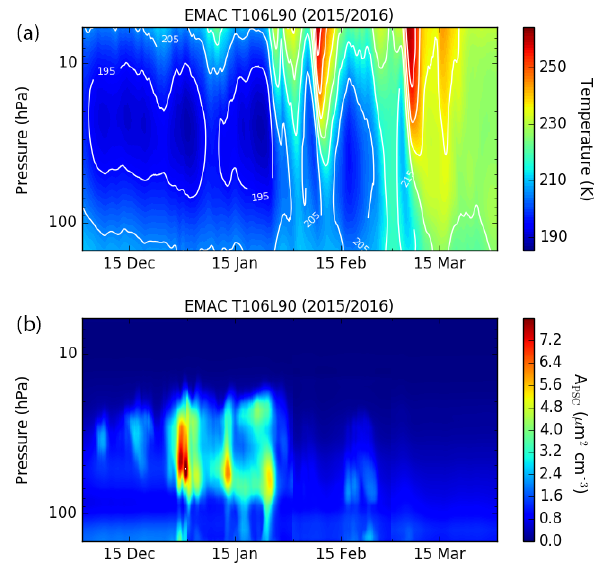
Figure 1. Temporal evolution of temperature (a) and surface area density of PSC particles (liquid plus solid) (b) at northern high lat- itudes (70–90 ◦ N) as a function of pressure during the 2015/2016 Arctic winter, as simulated with EMAC